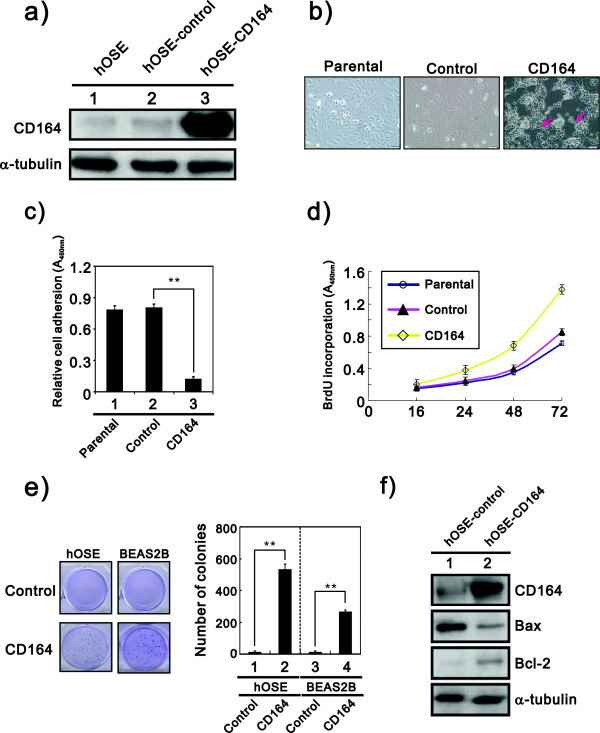
CD164 overexpression alters cell morphology and induces malignant transformation/anchorage independent growth in hOSE. a) Cell lysates from hOSE-CD164 cells were subjected to an immunoblot analysis with an antibody against the CD164 protein. α-tubulin was used as a loading control. b) The morphology of hOSE-CD164 cells compared with hOSE parental and hOSE-vector control cells by phase-contrast microscopy. (×100 magnification and Scale bars = 50 μm). c) The adhesive ability of hOSE-CD164 and control cells was detected by an adhesion assay. **p < 0.01 (three independent experiments were performed and the data are expressed as the means ± s.e.m.). d) Proliferation of hOSE-CD164 cells and control cells were analyzed using a BrdU proliferative assay (three independent experiments and data were mean ± s.e.m.). e) Effect of CD164 overexpression on the colony formation ability of hOSE cells. Soft agar colony formation of hOSE-CD164 and BEAS2B-CD164 cells paired with control cells was calculated after 28 days of culture. The graph showed the number of colonies (means ± s.e.m.) after 4 weeks of culture for three independent experiments. The p values (determined by Student’s t test) were relative to control cells. **p < 0.01 (three independent experiments and data were means ± s.e.m.). f) Cell lysates from hOSE-CD164 cells were subjected to immunoblot analysis for antibodies against anti-apoptotic Bcl-2 and apoptotic Bax protein. α-tubulin was used as a loading control.